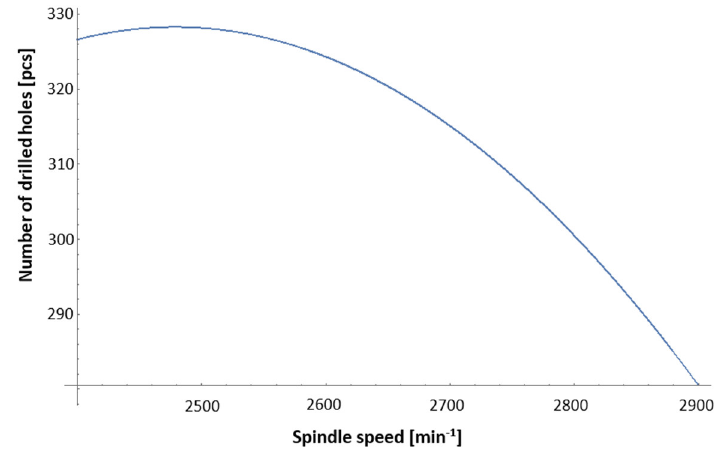
Figure 14. The course of dependence of the number of holes drilled up to the moment of tool damage in the range of the speeds used.